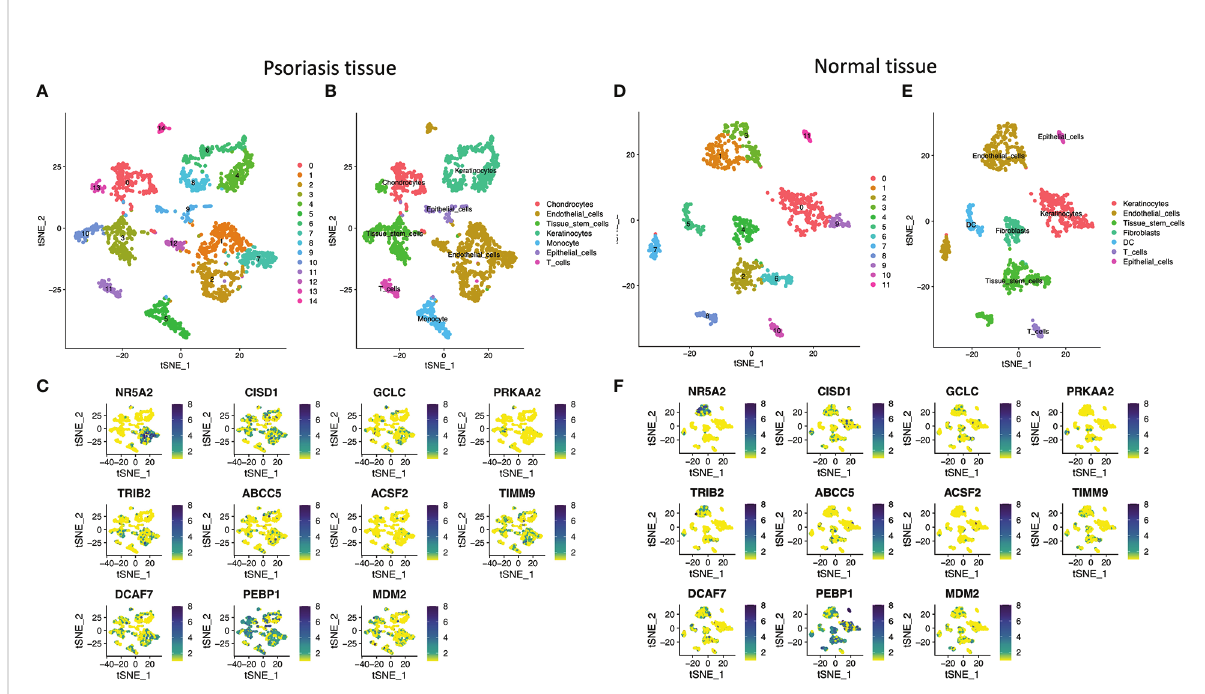
FIGURE 6 Cell-type classi fi cation in psoriasis and normal tissue. (A) and (D) t-SNE plot of 14 cell clusters in psoriasis tissue and healthy tissue. (B) and (E) t- SNE plot exhibiting the cell types in psoriasis. (C) and (F) t-SNE plot of the marker